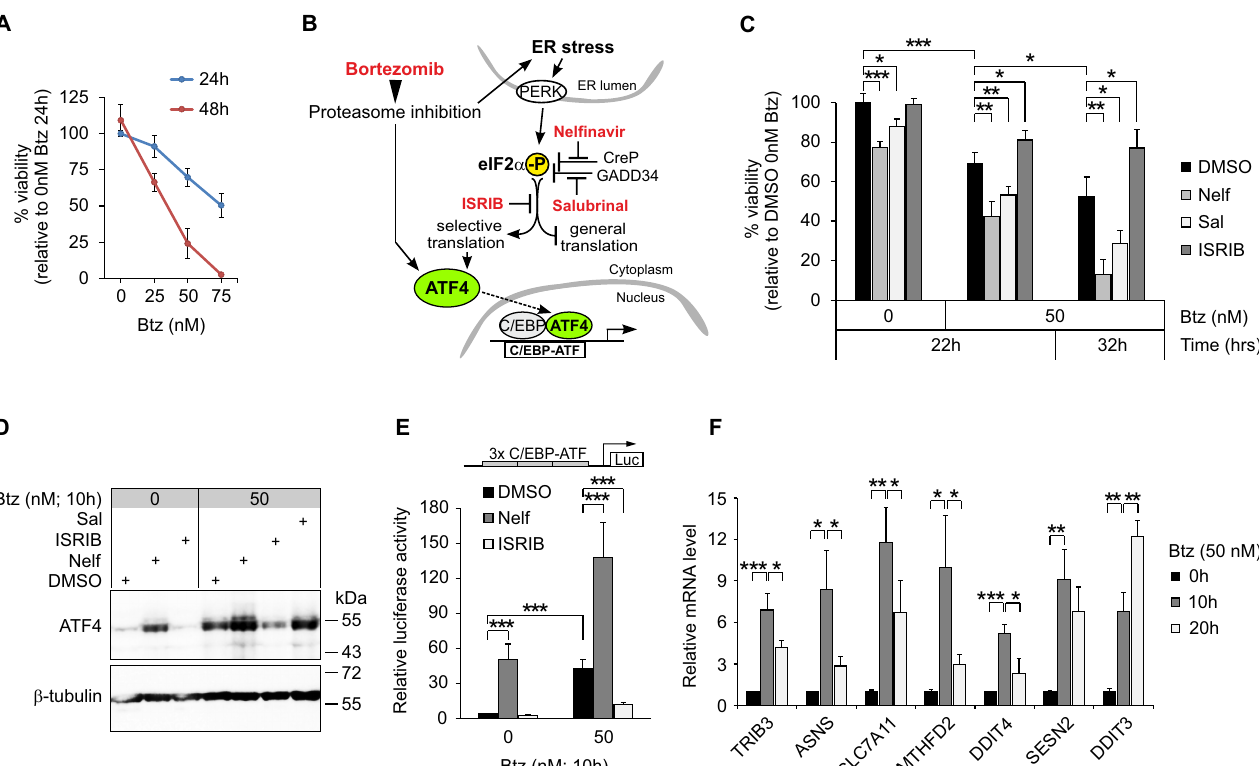
Figure 1. Pharmacological compounds targeting the eIF2 α –ATF4 pathway affect bortezomib cytotoxicity in HepG2 cells. ( A ) Viability of HepG2 cells treated with different concentrations of bortezomib (Btz) for 24 or 48 h. Cell viability was measured using the Alamar Blue assay ( n = 3–7) and is presented relative to vehicle-treated 24 h cells. ( B ) Schematic representation of the eIF2 α –ATF4 stress response pathway in relation to Btz. Chemical modulators used in this study are highlighted in red. ( C ) Viability of HepG2 cells treated with Btz (50 nM), nelfinavir (Nelf; 20 µ M), salubrinal (Sal; 20 µ M), ISRIB (5 nM) or vehicle (DMSO), as indicated. Viability was measured using the Alamar Blue assay ( n = 4–5) and is presented relative to DMSO-treated cells without Btz. ( D ) ATF4 protein immunoblot from HepG2 cells treated with Btz along with 20 µ M Nelf, 20 µ M Sal, 50 nM ISRIB or DMSO, as indicated. The blot shown is representative of two independent experiments. ( E ) Luciferase reporter assay for ATF4 transcriptional activity in cells treated as in panel D. Activity of the reporter plasmid containing three copies of the C/EBP–ATF composite site is presented relative to DMSO-treated (0 nM Btz) cells ( n = 3–7). ( F ) RT-qPCR quantification of known ATF4 pathway target genes in HepG2 cells treated with Btz ( n = 4). Data are presented relative to the average expression level in cells without Btz (0 h). For all panels, graphs display the means ± SD. * p < 0.05, ** p < 0.01, *** p < 0.001 using two-tailed t tests followed by Holm–Bonferroni